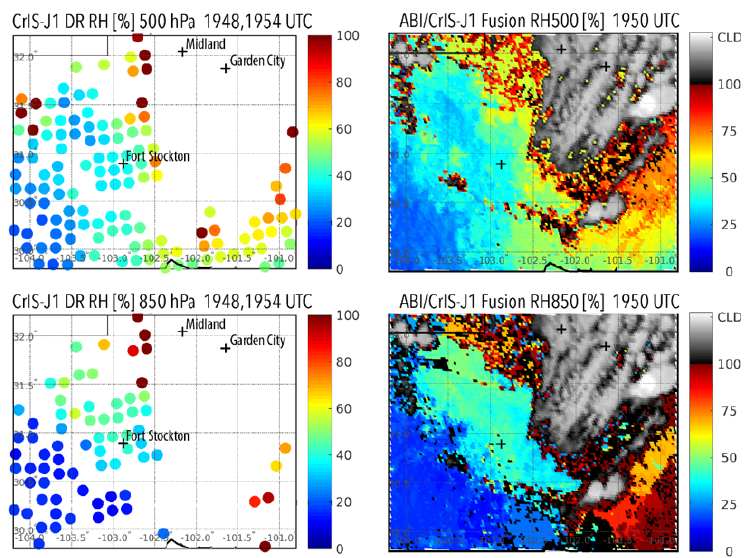
Figure 10. Left : CrIS on JPSS-1 RH [%] retrievals at 500 and 850 hPa at 1950 UTC on 24 May 2022; right : ABI/CrIS-J1 fusion of RH at 500 and 850 hPa, with ABI Band 15 (12.3 μ m) brightness temperatures in the background.